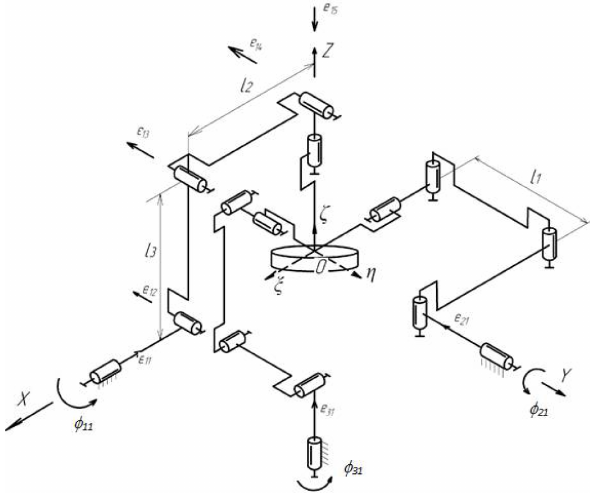
Figure 1. Mechanism of a parallel manipulator with 3 degrees of freedom.